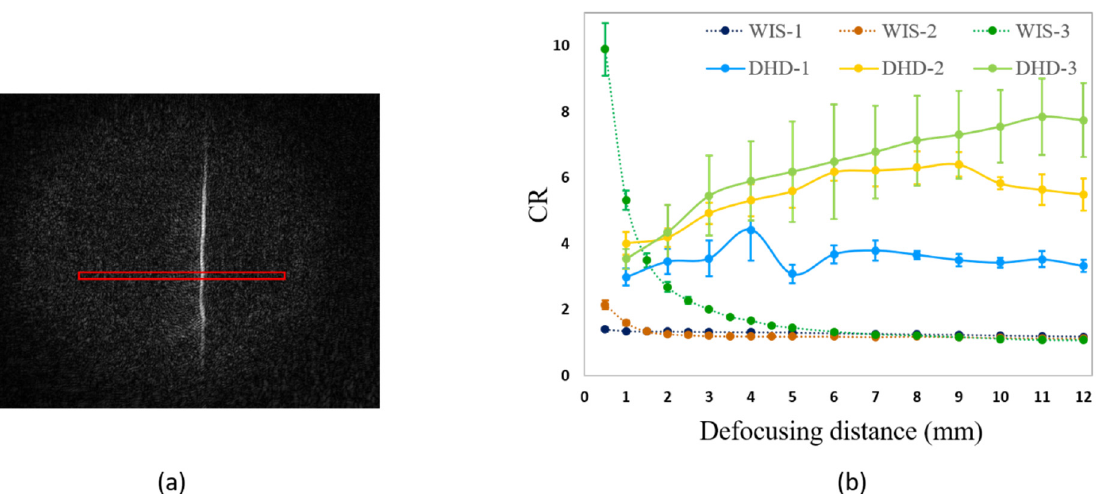
Figure 7. ( a ) The interesting area for the calculation of the CR value; ( b ) the CR value varying with the defocus distance.